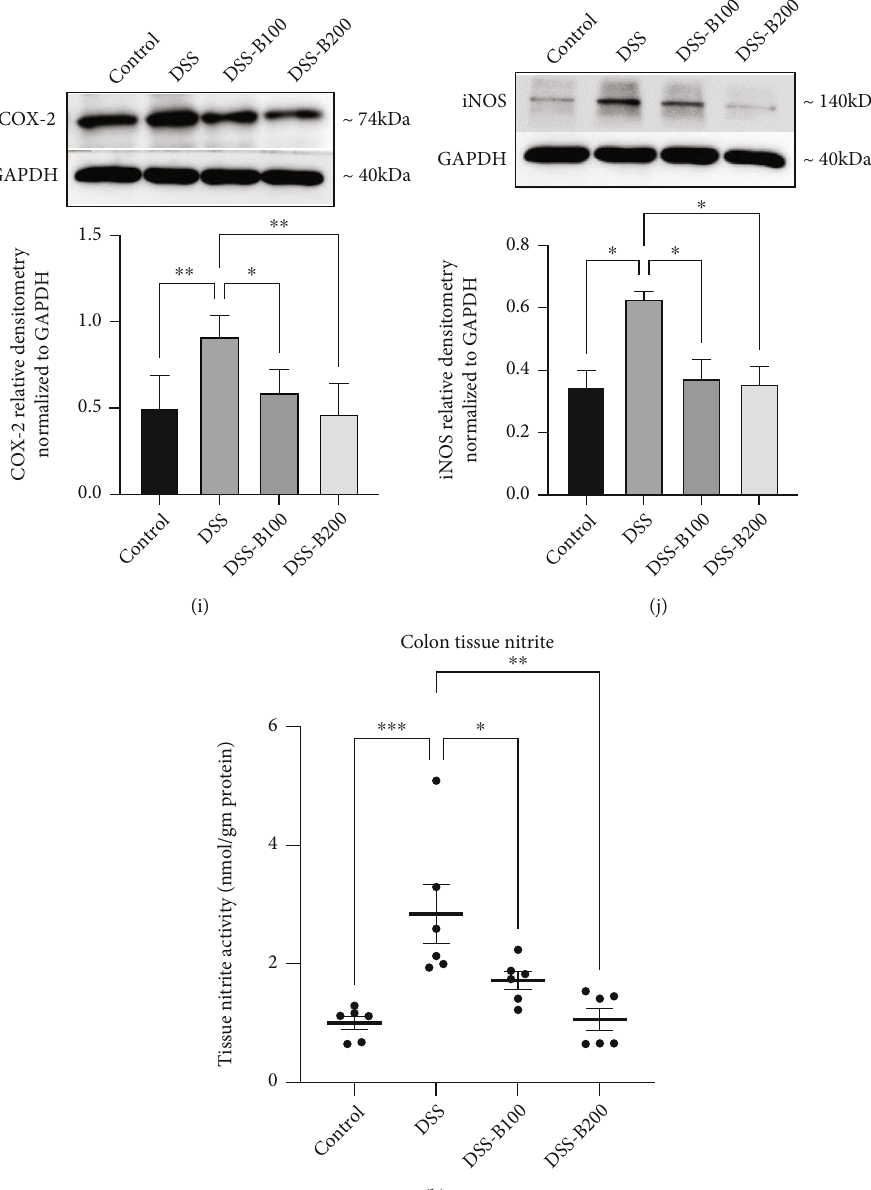
Figure 4: E ff ect of bisabolol on proin fl ammatory cytokines and mediator protein and mRNA expression. DSS administration signi fi cantly elevated proin fl ammatory cytokine concentrations. α -Bisabolol treatment signi fi cantly prevented the increase in proin fl ammatory cytokines at the protein (IL-6 (a), IL-1 β (b), TNF- α (c), and IL-17A (d)) and mRNA ((IL-6 (e), IL-1 β (f), TNF- α (g), and IL-17A (h)) levels. DSS administration also increased COX-2 and iNOS protein levels. α -Bisabolol treatment signi fi cantly downregulated protein expression (i, j). DSS administration signi fi cantly increased tissue nitrite levels, and α -bisabolol treatment prevented this increase (k). The density of immunoblots normalized to GAPDH. Eight ( n = 8 ) animals used for ELISA, six ( n = 6 ) animals used for mRNA, and six ( n = 6 ) animals used for Western blot and tissue nitrite level measurements. The data is expressed as mean ± SEM . ∗ p < 0 : 05 , ∗∗ p < 0 : 01 , and ∗∗∗ p < 0 : 001 . ns: not signi fi